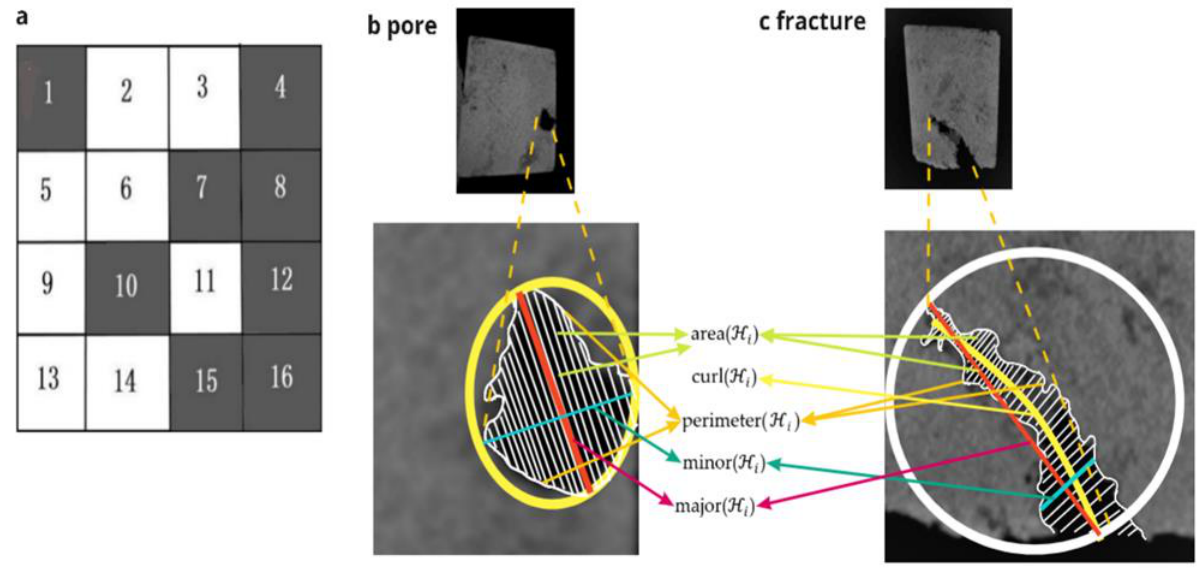
Figure 1. ( a ). Step-wise procedure to find k -INs of any pixels. area ( H i ), major ( H i ), minor ( H i ), perimeter ( H i ) and curl ( H i ) of a fracture and pore are shown in ( b , c ), respectively. Quite evidently, the major value of a fracture is larger than that of a pore.